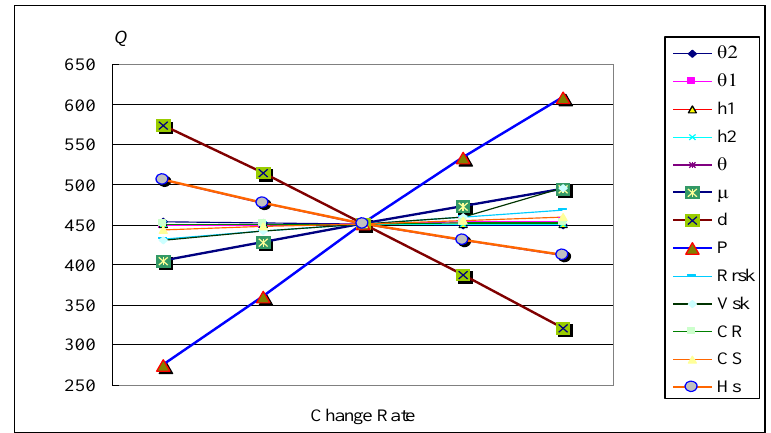
Figure 6. PTCD vs. change rate for economic production model with facility unreliability.